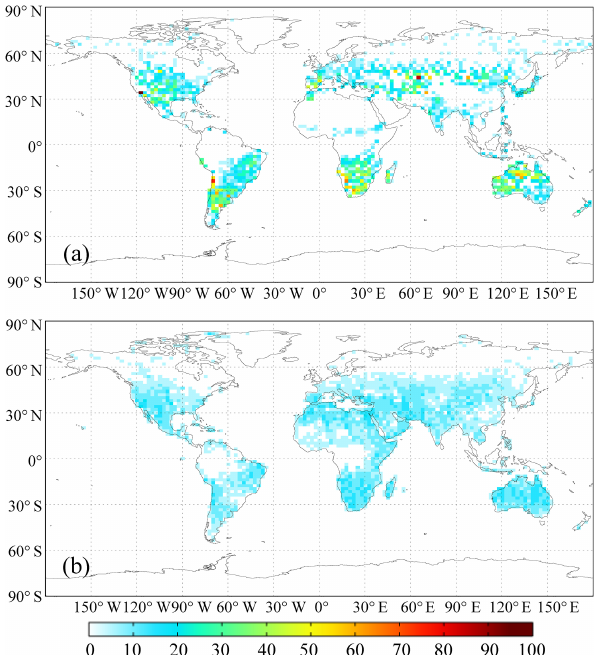
Figure 1. Data amount in each grid cell (2 ◦ × 2.5 ◦ ) of ACOS XCO 2 used in this study ( a , GOSAT; b , OCO-2).